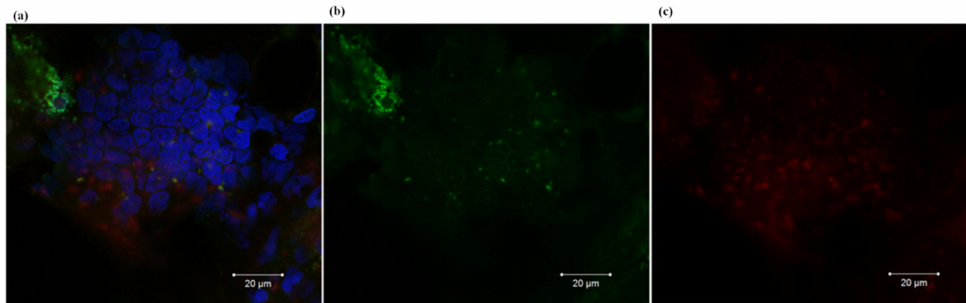
Figure 4. Microdistribution of DARP-Lip(Bn) and EC1-LoPE in the tumor. ( a ) Overlaid confocal images of tumor sections in blue (Hoechst 33342), green (Cy3) and red channel (Cy5.5) (Hoechst 33342: excitation femtosecond laser 740 nm, emission range 400–550 nm; Cy3: excitation laser 514 nm, emission range 550–630 nm; Cy5.5: excitation laser 561 nm, emission range 650–740 nm). ( b , c ) Confocal images of tumor sections in green and red channels respectively.